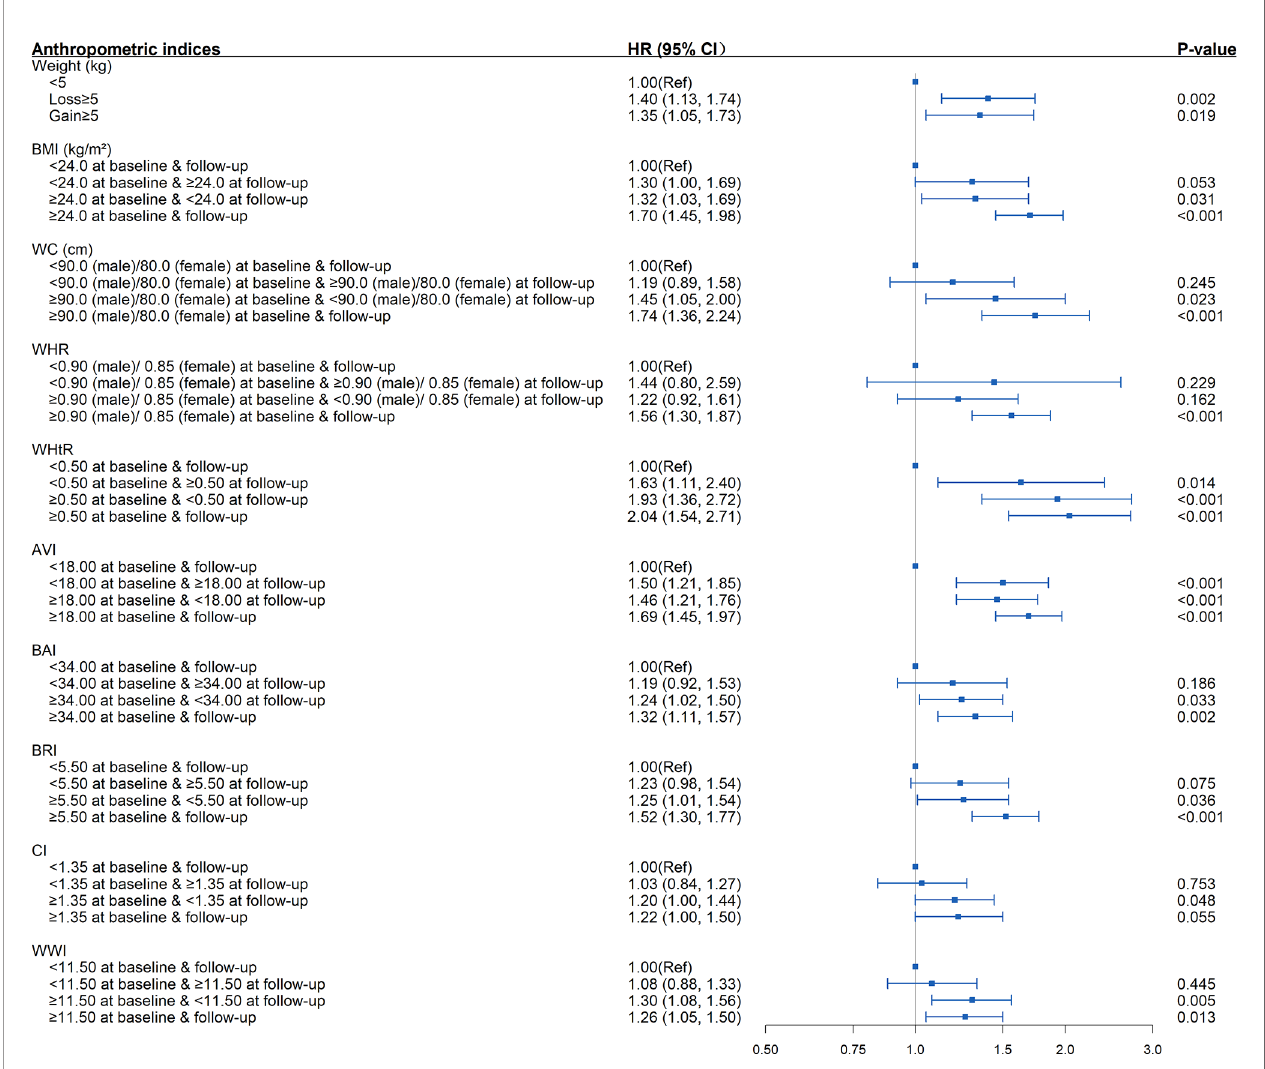
FIGURE 4 | Association between dynamic changes of separate anthropometric indices with the development of diabetes (weight, body mass index [BMI], waist circumference [WC], waist-to-hip ratio [WHR], waist-to-height ratio [WHtR], abdominal volume index [AVI], body adiposity index [BAI], body roundness index [BRI], conicity index [CI], weight-adjusted-waist index [WWI]). The correlation was assessed by multivariate cox regression analysis, adjusted by sex, age, smoking status, drinking status, and family history of diabetes at baseline and differences of FPG, TG, TC, HDL, LDL, SBP, DBP between the baseline and follow-up. Hazard ratios (HRs) of the anthropometric indices were represented as the squares and 95% con fi dence intervals (CIs) by the lines through the